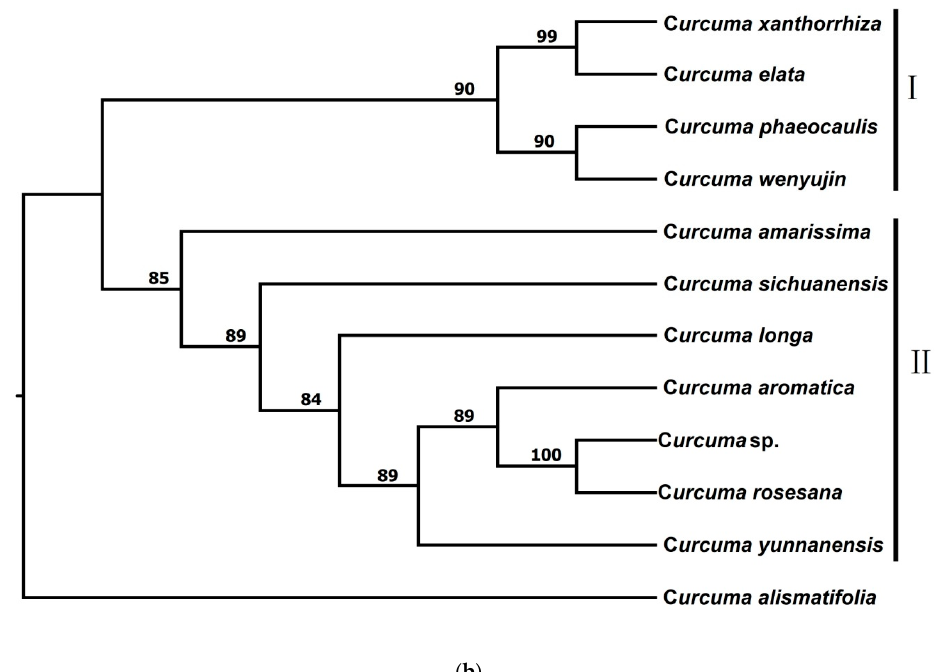
Figure 2. Phylogenetic trees of Curcuma inferred from maximum likelihood (ML) using ( a ) full concatenated super-matrix data and ( b ) concatenated 8574 loci by STACKS. The ML bootstrap values were presented on the species clade. Only bootstrap values greater than 50 are shown. In Figure 2a, Group I consisted of C. elata , C. xanthorrhiza , and C. amarissima ; Group II consisted of C. aromatica , C.